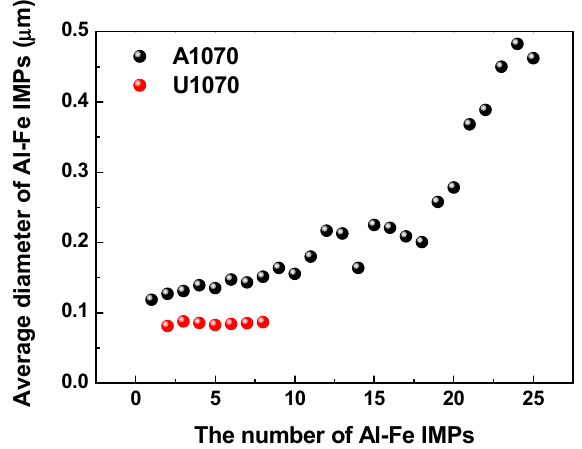
Figure 10. Size and number of Al–Fe IMPs at 300 µ m 2 from FE-EPMA and FE-TEM analyzes.